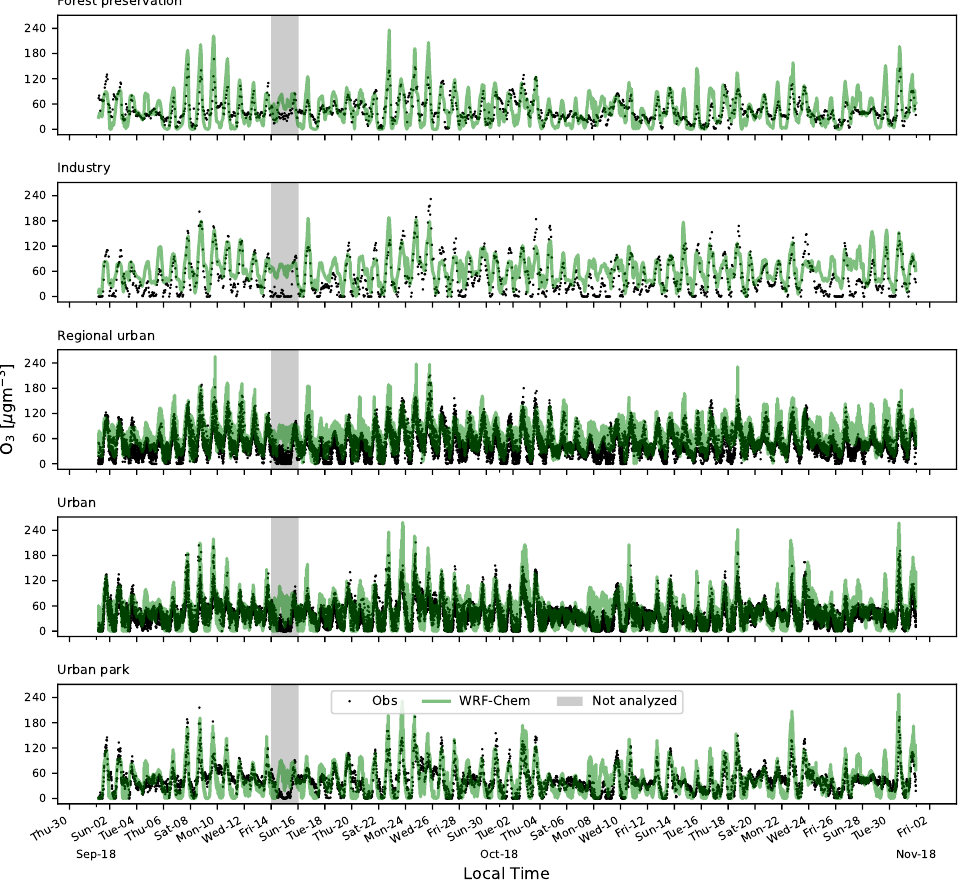
Figure 5. Modeled versus measured surface ozone concentrations for September–October 2018 by station type. Fifty-six stations with hourly concentrations were considered to obtain this